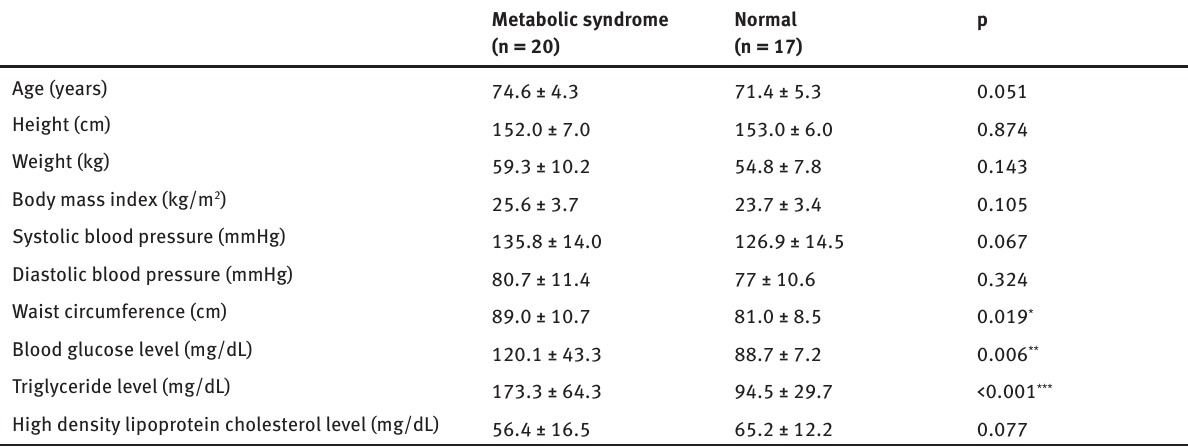
Table 1: General characteristics of the patients